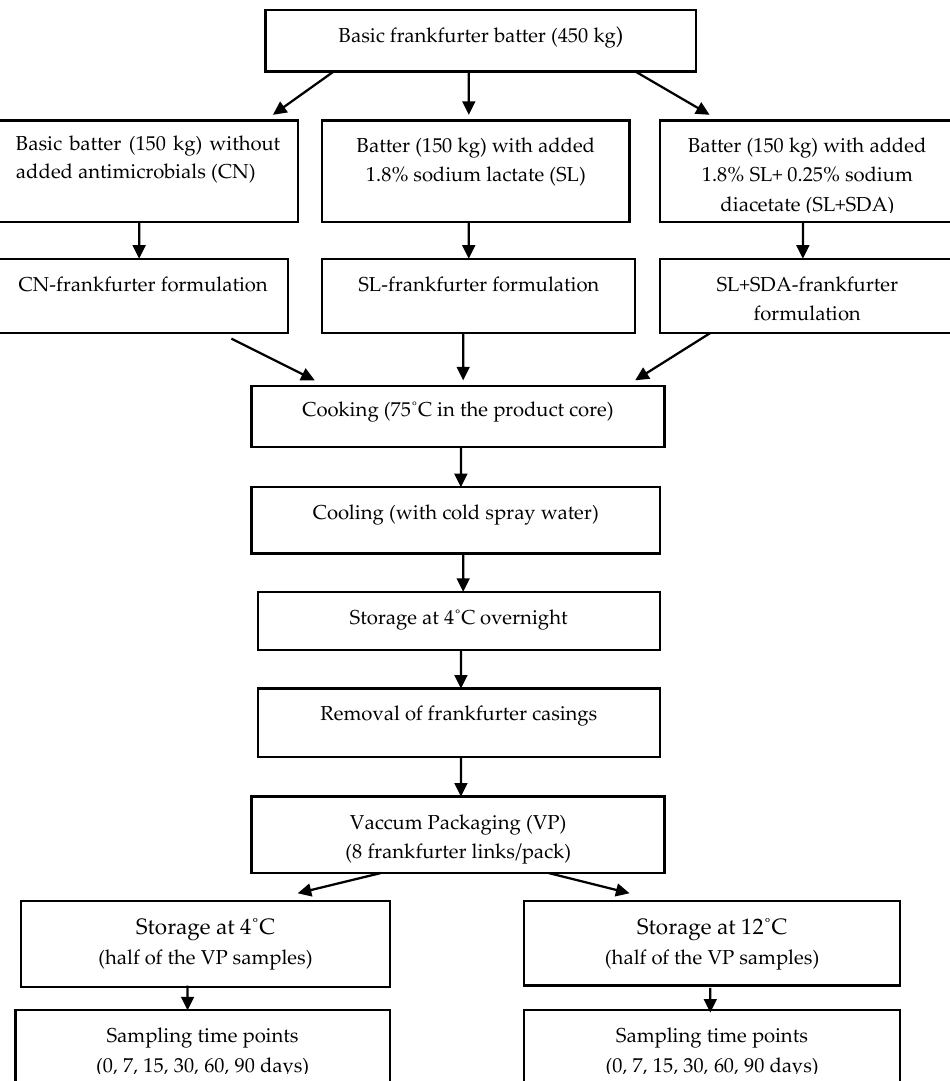
Figure 1 : Preparation, formulation, storage and sampling of frankfurter treatments 39 Figure 1. Preparation, formulation, storage and sampling of frankfurter